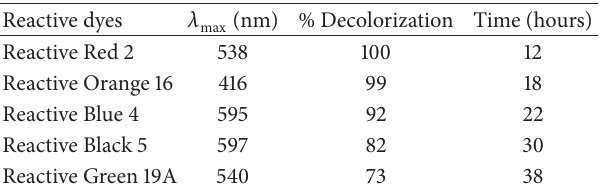
Table 2: Decolorization of structurally different azo dyes by Para- coccus s p. GSM2.